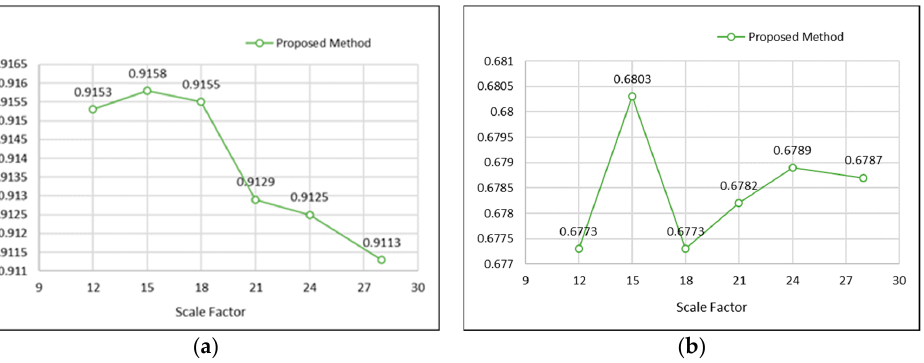
Figure 10. ( a ) MEF-SSIM analysis of applying different scale factors. ( b ) Q AB / F analysis of applying different scale factors.